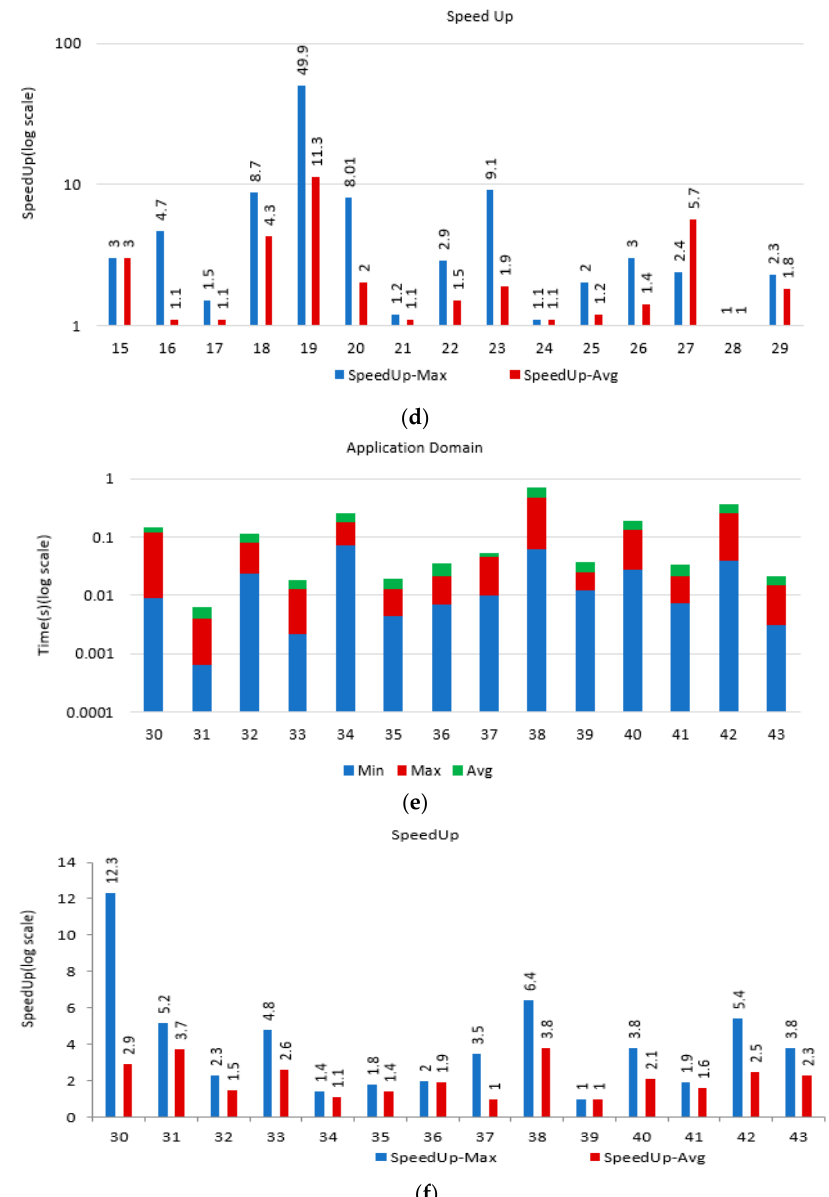
Figure 9. Domain wise execution time comparison ( a – c ) and speedup ( d – f ).